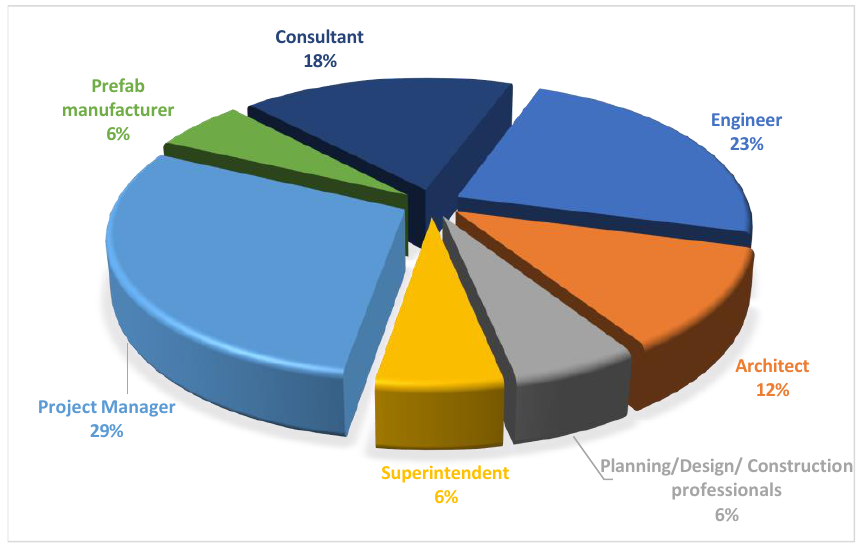
Figure 5. Participants' Demographic Information.